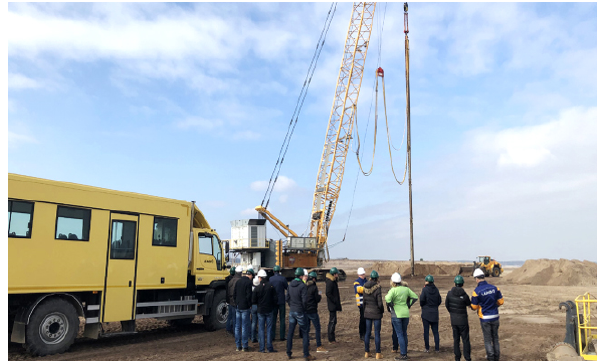
Figure 3. Field investigation on 21 March 2019 into open-pit test mine (Fig. 2). Source: i 2 MON